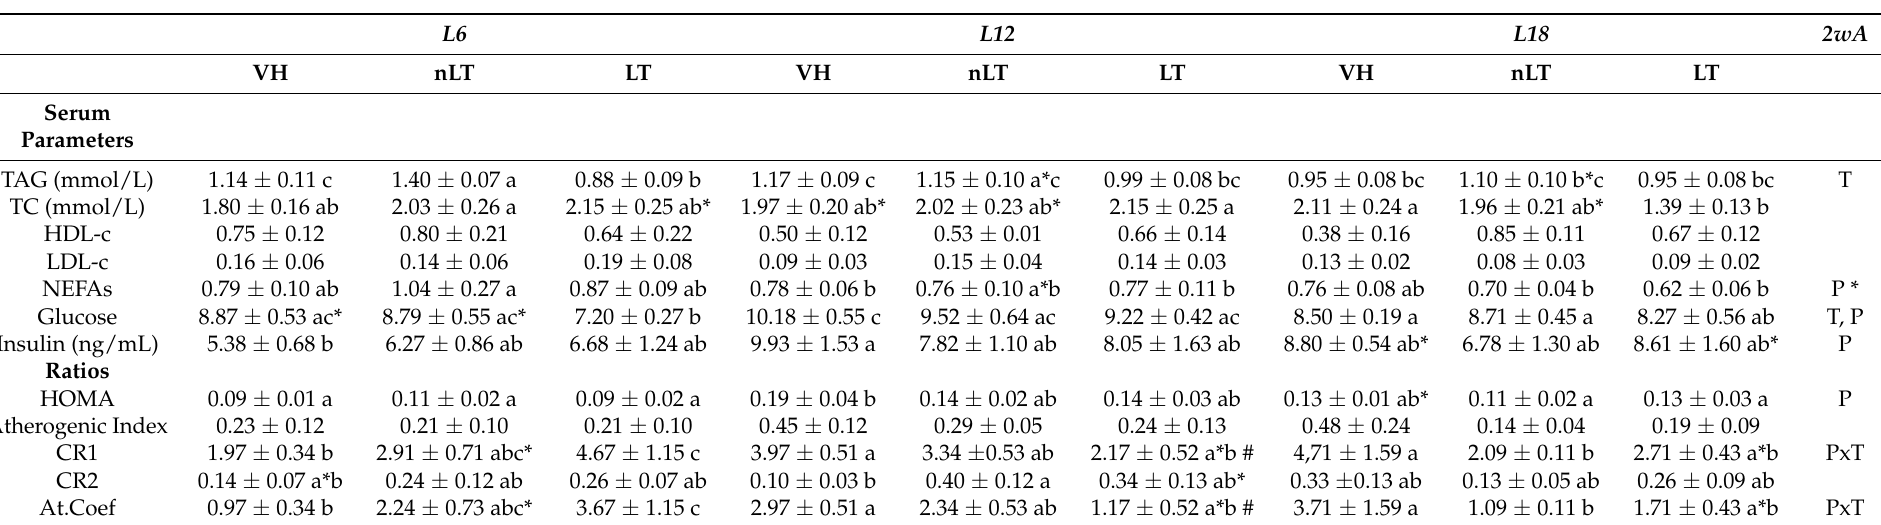
Table 1. Plasma parameters and atherogenic indices in Fischer 344 rats exposed to different photoperiods and supplemented with local or non-local tomato lyophilizate or vehicle for 7